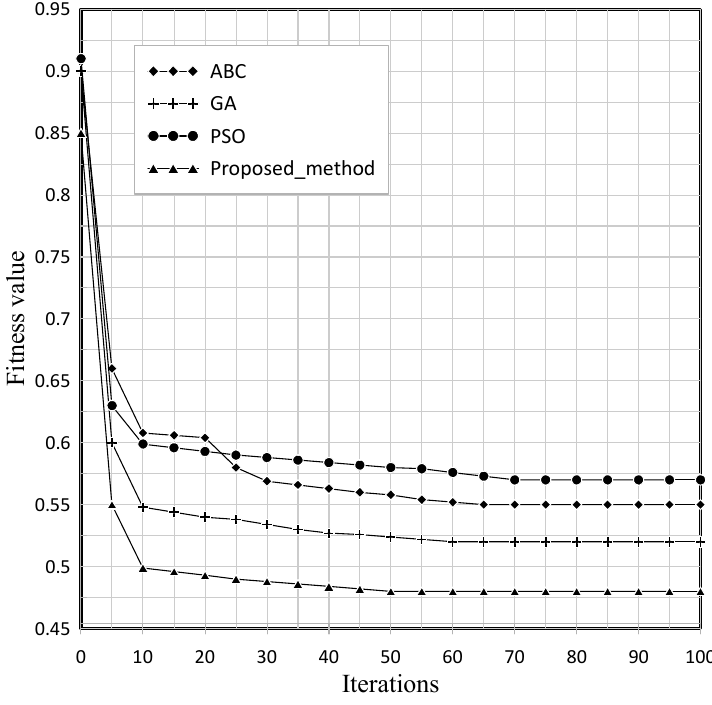
Figure 10. The result for fitness in 100 iterations .